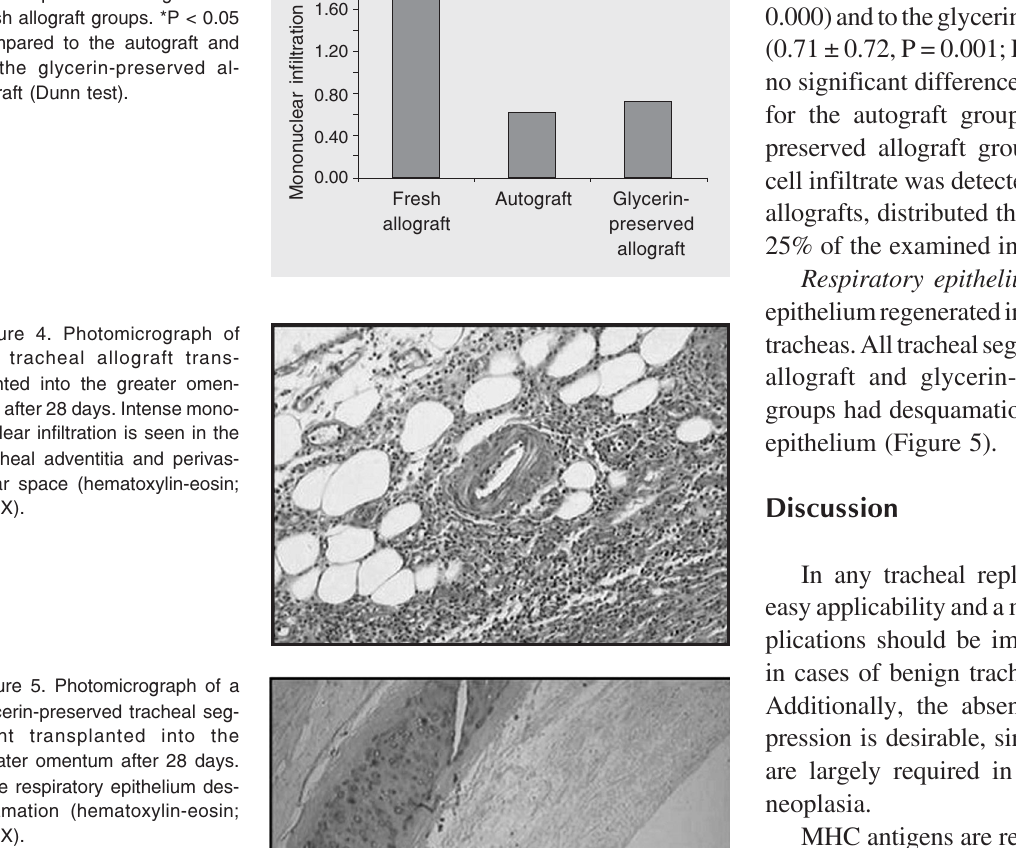
Figure 5. Photomicrograph of a glycerin-preserved tracheal seg- ment transplanted into the greater omentum after 28 days. Note respiratory epithelium des- quamation (hematoxylin-eosin;